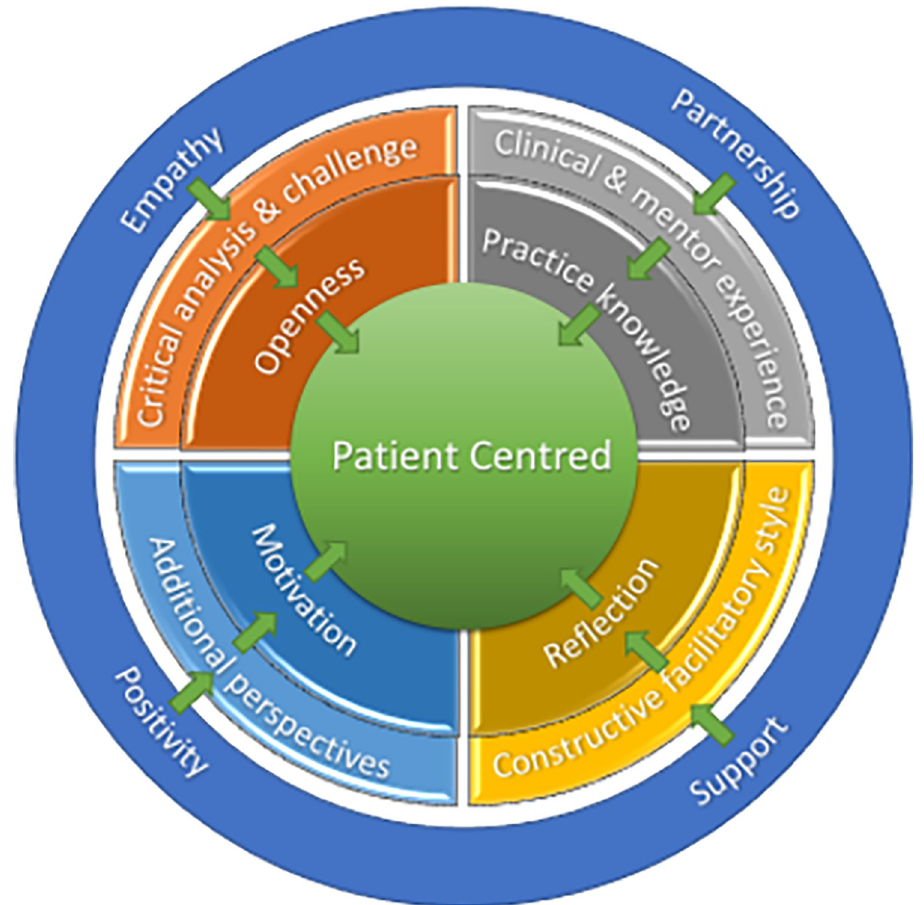
Fig 4. Emerging model of MCP–integration of patient, mentee and